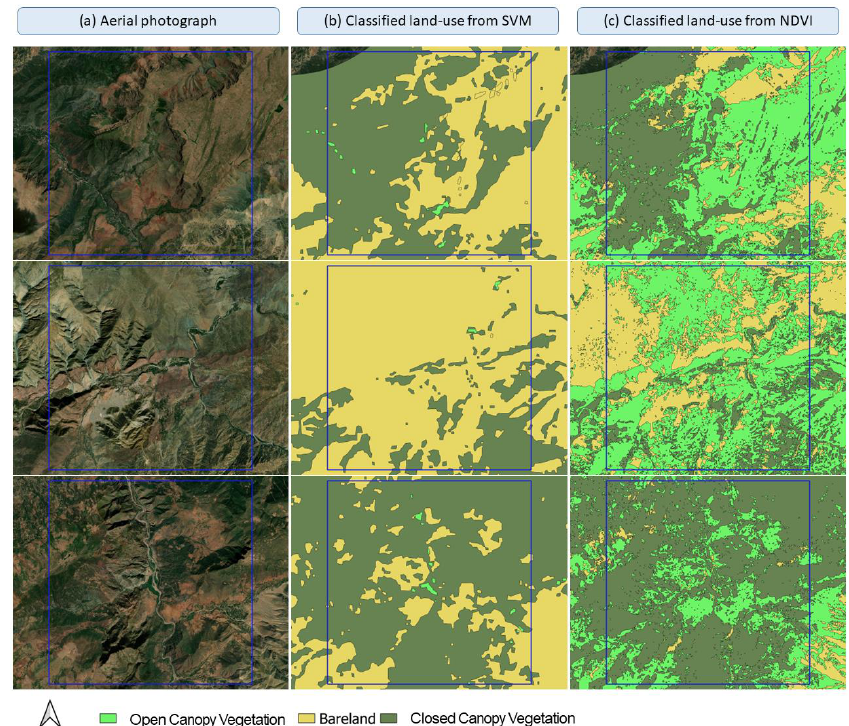
Figure 9. Comparison of ( a ) map derived from aerial photograph dataset tile in QGIS, ( b ) land-use classes from the SVM classification approach, ( c ) land-use classes from the NDVI rules-based classification approach in three validation windows (blue) of 5 km × 5 km in the High Atlas Mountains of Morocco.